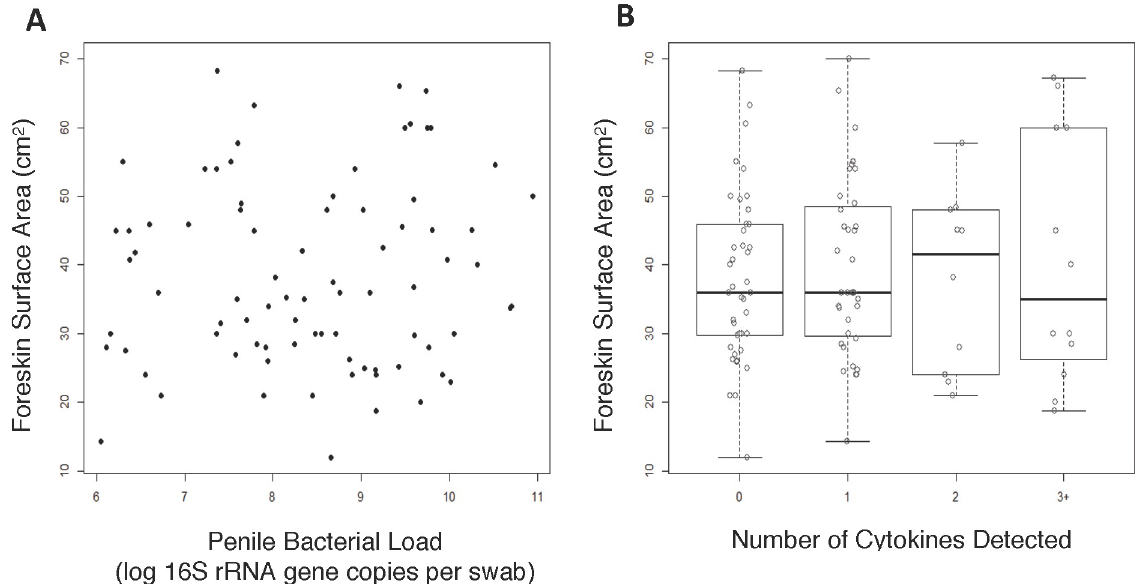
Fig 1. Foreskin surface area is not associated with (A) total bacterial load nor (B) number of cytokines detected. Foreskin surface area was measured on tissues removed during circumcision for HIV-1 prevention (n = 82). Penile bacterial load was estimated as 16S qPCR copy number from a swab of the coronal sulcus. Cytokines were measured in the same swab by a multiplexed enzyme-linked immunosorbent assay.